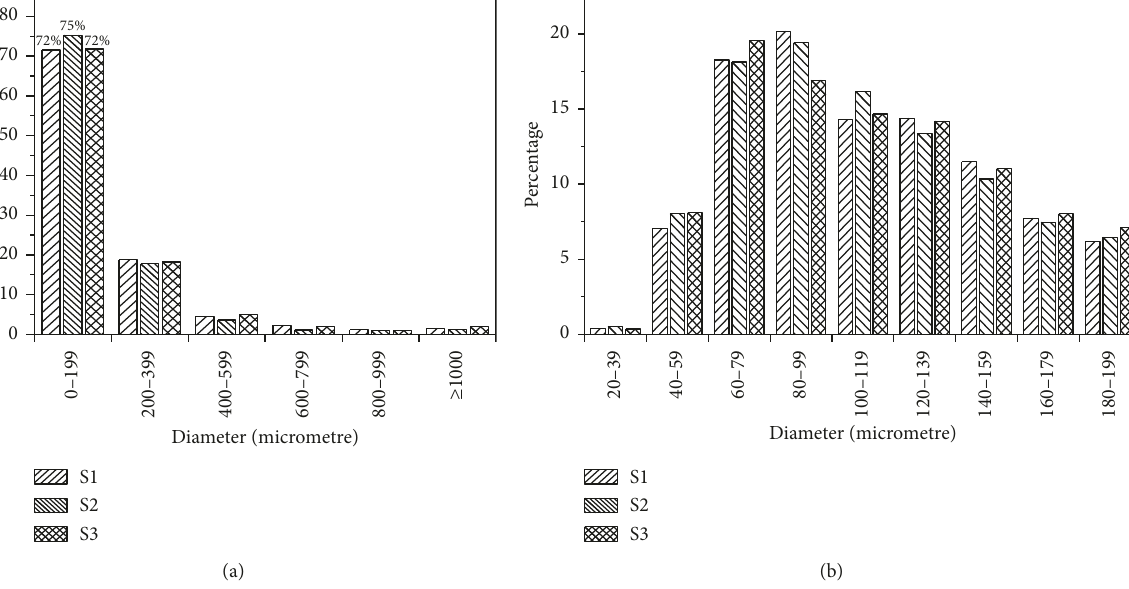
Figure 8: (a) Distribution of diameter of overall pores and (b) distribution of diameter in the range 0 ∼ 199 μ